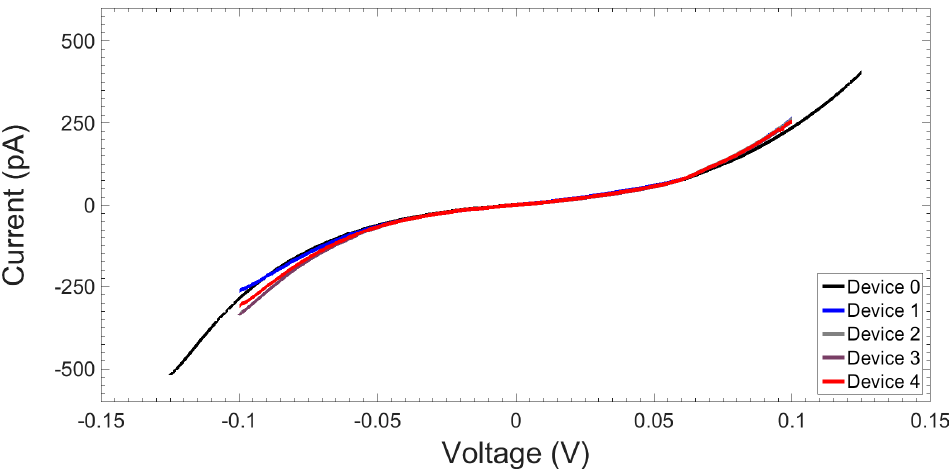
Figure 4. Measured I-V curve showing leakage currents in air for the horizontal coplanar (~215 nm) nanogap test device (Device 0) and the four devices (Devices 1–4) used in later PNA DNA binding experiments.